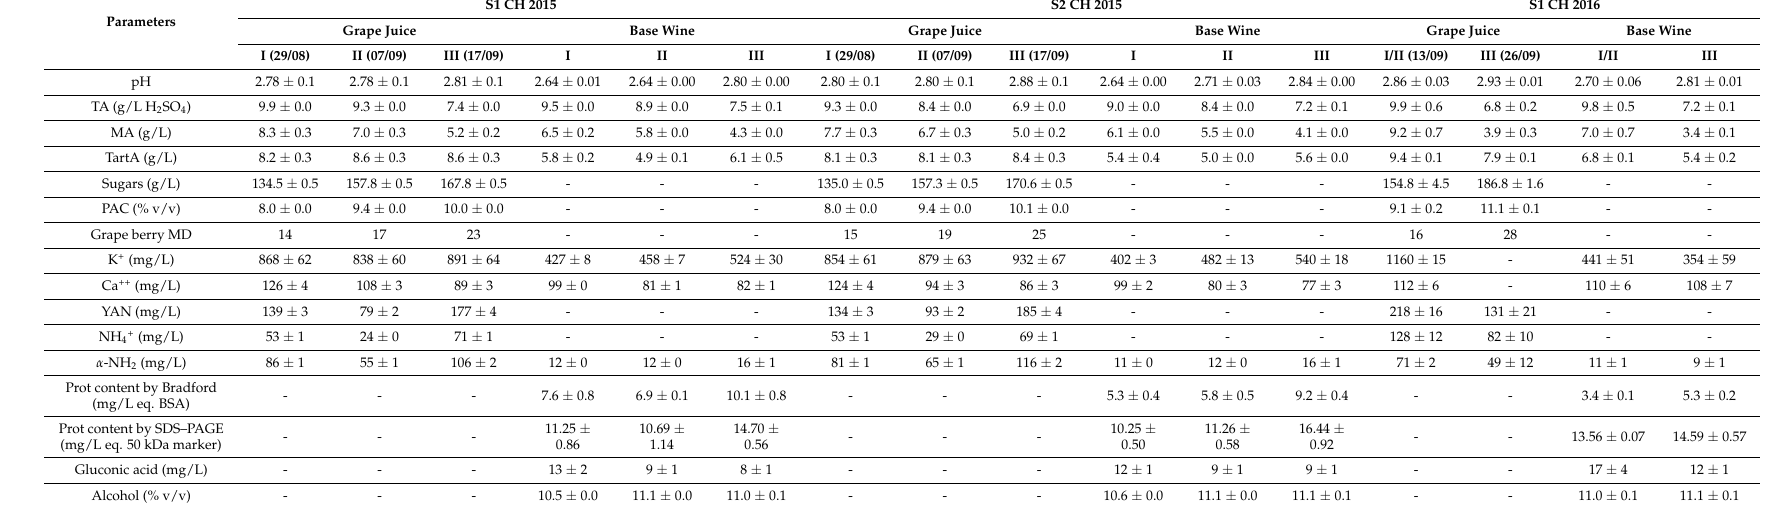
Table 2. Oenological parameters of Chardonnay grape juices and base wines at different grape berry maturity levels.